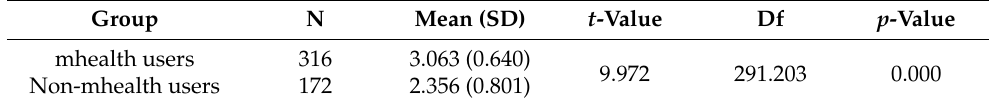
Table 2. Independent t -test